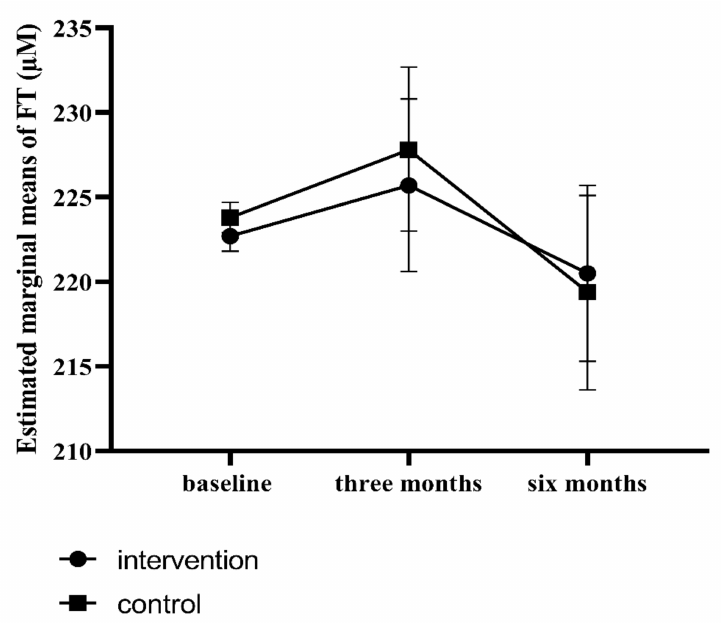
Figure 2. Estimated marginal means from baseline-correctedˆ GEE analyses of serum FT levels.